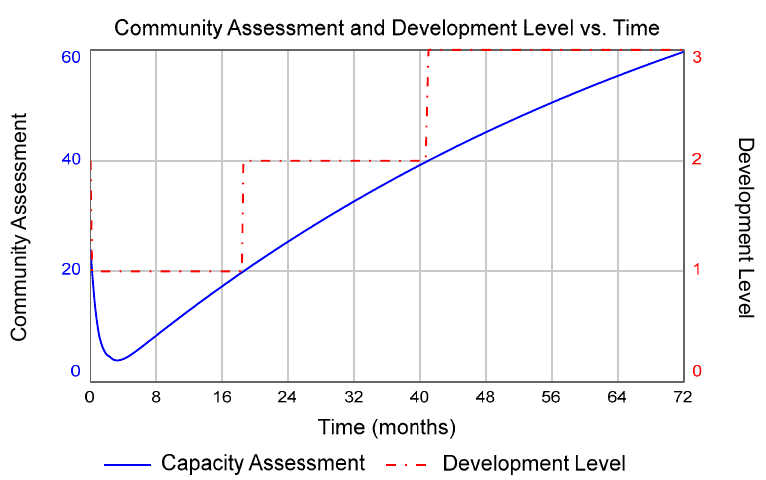
Figure 14. Variation of community capacity assessment and community development over 72 months (six years) assuming capacity dependency and an enabling environment.